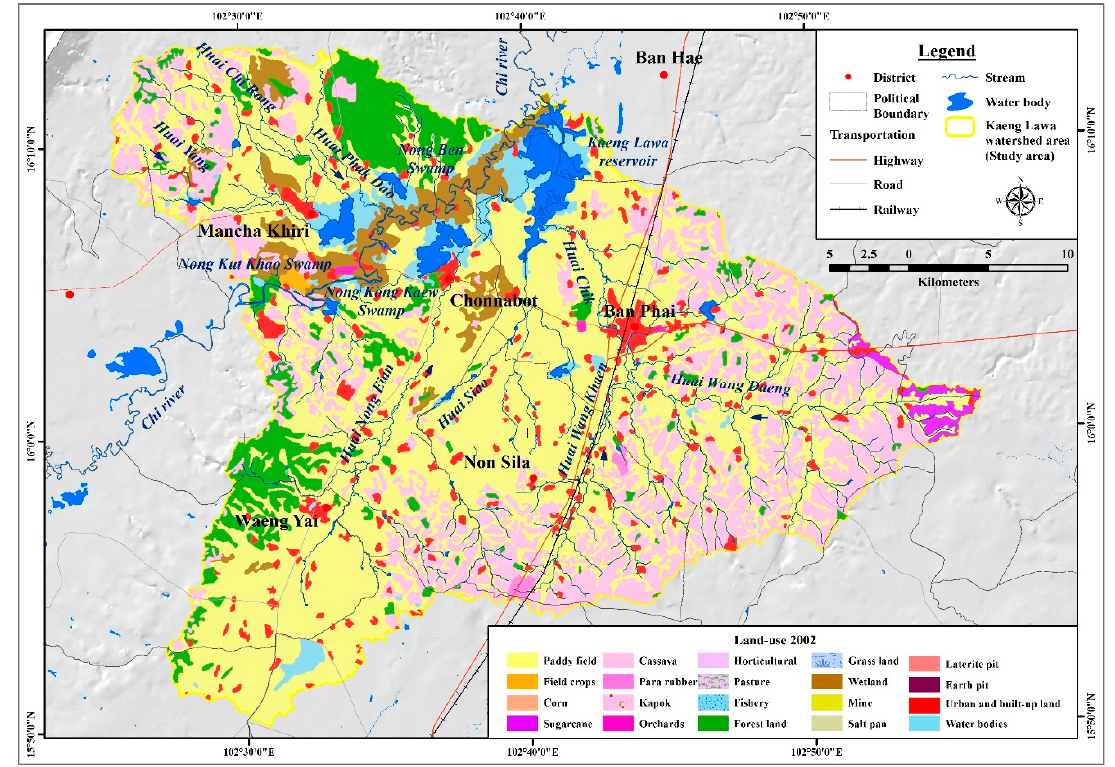
Figure 6. Land-use patterns in 2002 of KLs area, Khon Kaen Province.